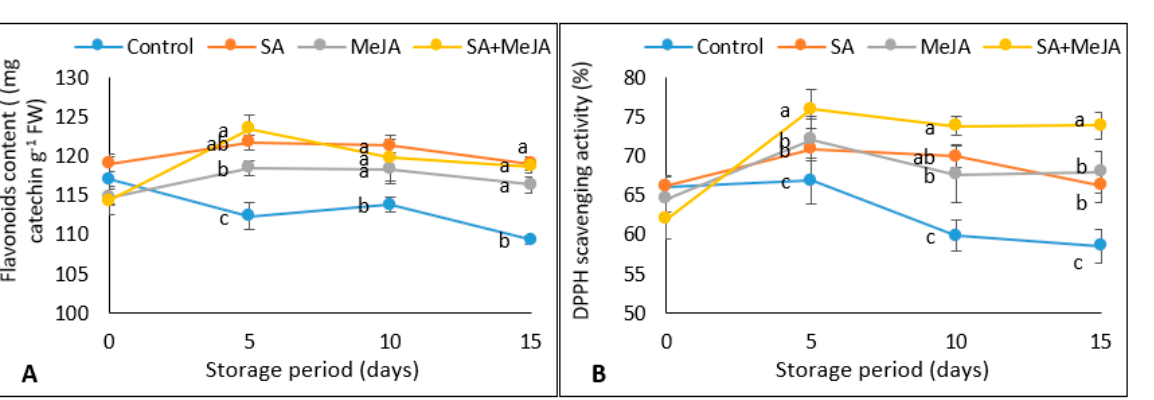
Figure 6. Effects of salicylic acid (SA), methyl jasmonate (MeJA), or their combination postharvest treatments on ( A ) flavonoids content and ( B ) antioxidant capacity (DPPH) of pomegranate arils stored at 5 °C for 15 days. The presented data are the mean of three replicates ± standard error. Different letters present significant differences between treatments at same storage point according to the Duncan test at p < 0.05.